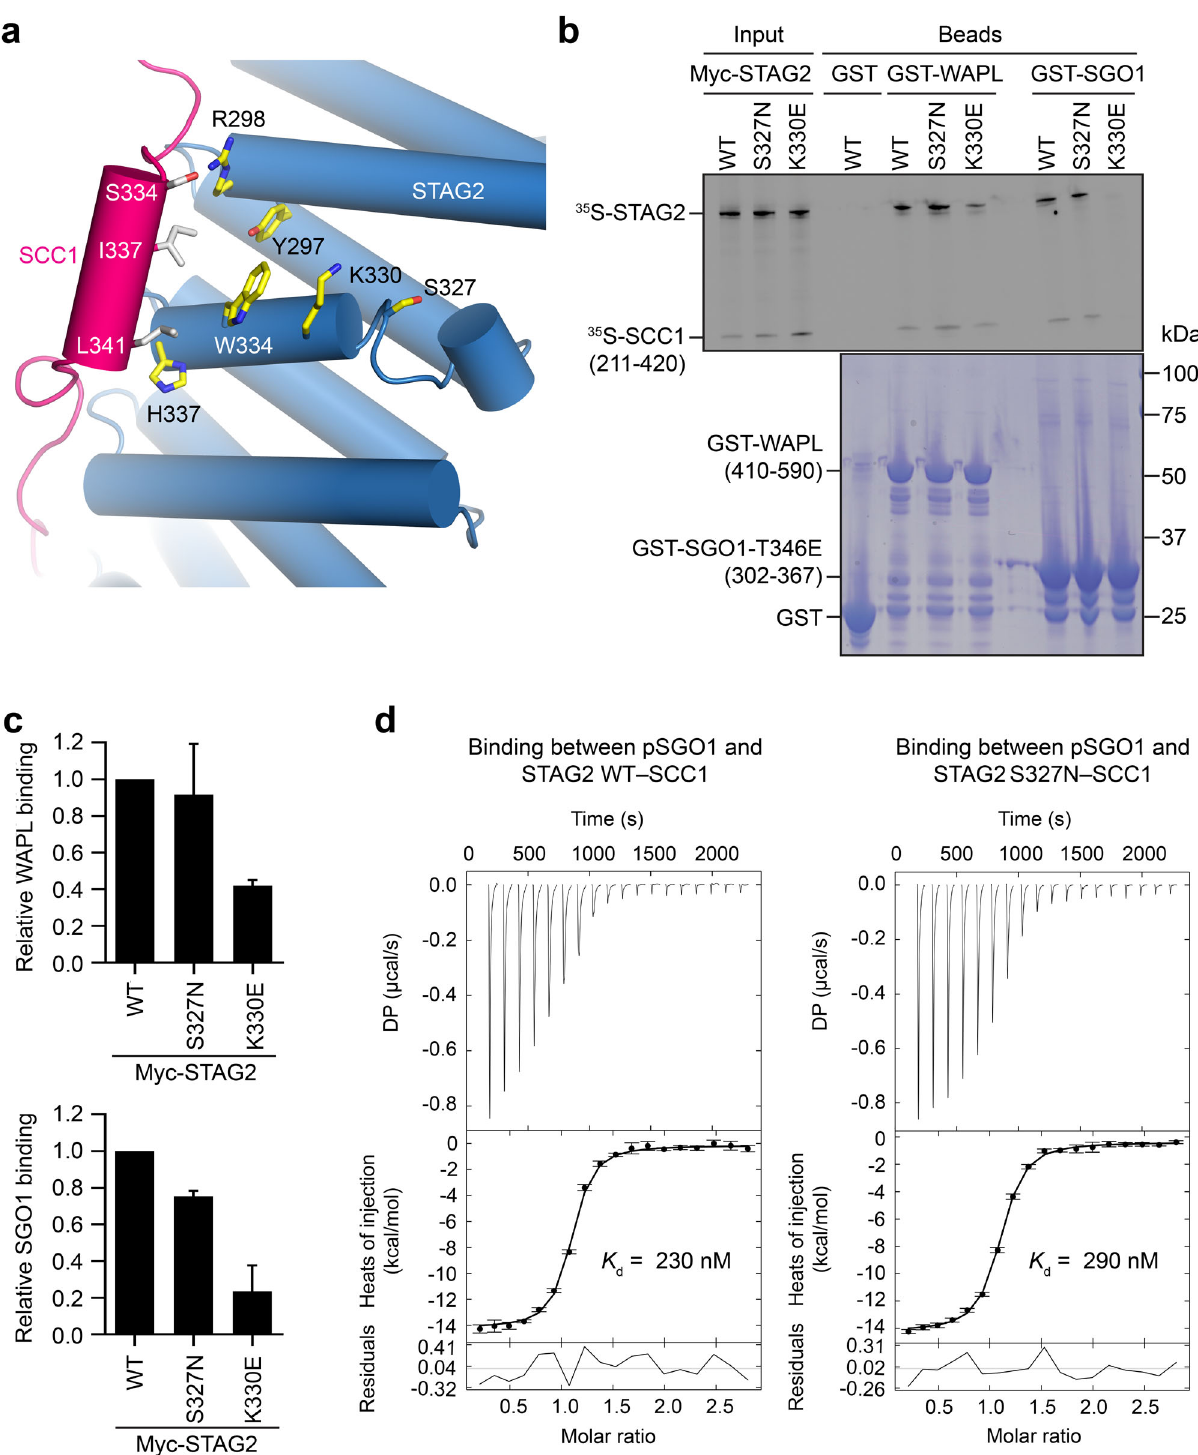
Fig. 6 STAG2 p.Ser327Asn retains binding to WAPL and SGO1 in vitro. a Cartoon diagram of the crystal structure of human STAG2 – SCC1, with Ser327 and neighboring residues shown in sticks . b In vitro binding of STAG2 – SCC1 to GST-WAPL or GST-Sgo1. GST was used as the negative control. Top and bottom panels show the autoradiograph and Coomassie staining of the binding reactions, respectively. c Quanti fi cation of the relative WAPL-binding and SGO1-binding activities of STAG2 – SCC1 WT, p.Ser327Asn (Ser327Asn), and Lys330Glu (K330E) (normalized to WT) in b . Mean ± SD, n = 3 independent experiments. For WAPL binding, WT vs. S327N, p = 0.6271, not signi fi cant; WT vs. K330E, p < 0.0001. For SGO1 binding, WT vs. S327N, p = 0.0002, p < 0.05; WT vs. K330E, p = 0.0007, p < 0.05. All p- values were based on t -test. d ITC graphs of the binding between pSGO1 and SA2 – SCC1 complexes (WT and p.Ser327Asn), with the dissociation constants ( K d )